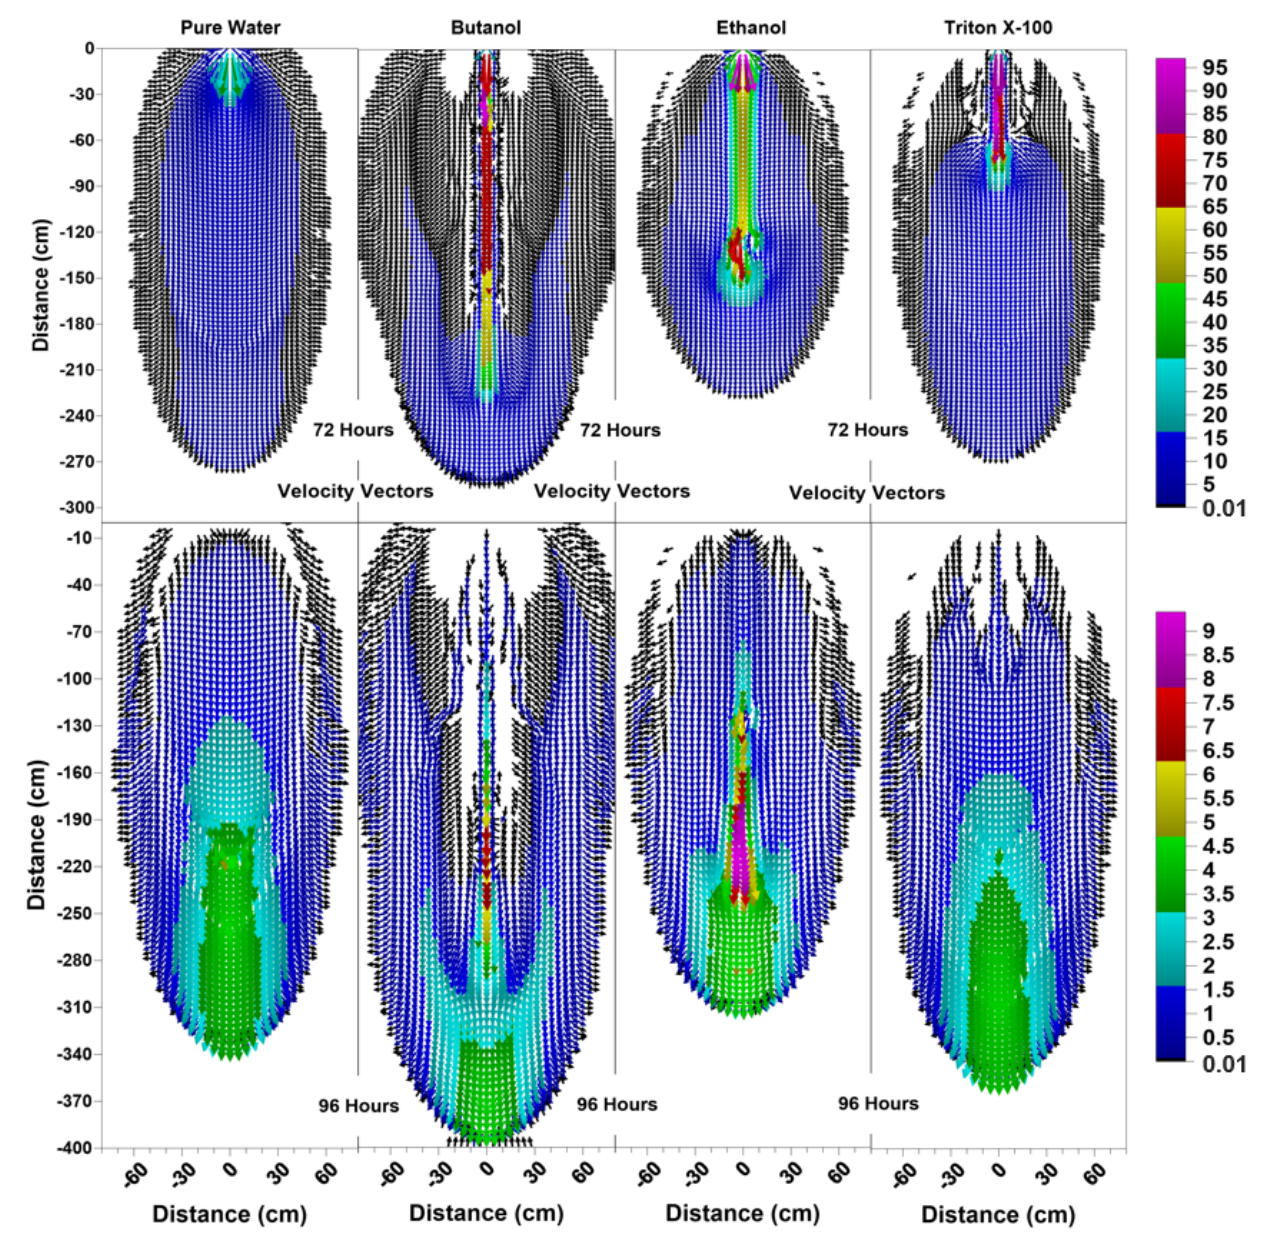
Figure 7. Velocity vector profiles (cm/day) at 72 h and 96 h for pure water, butanol, ethanol and Triton X ‐ 100 solutions.